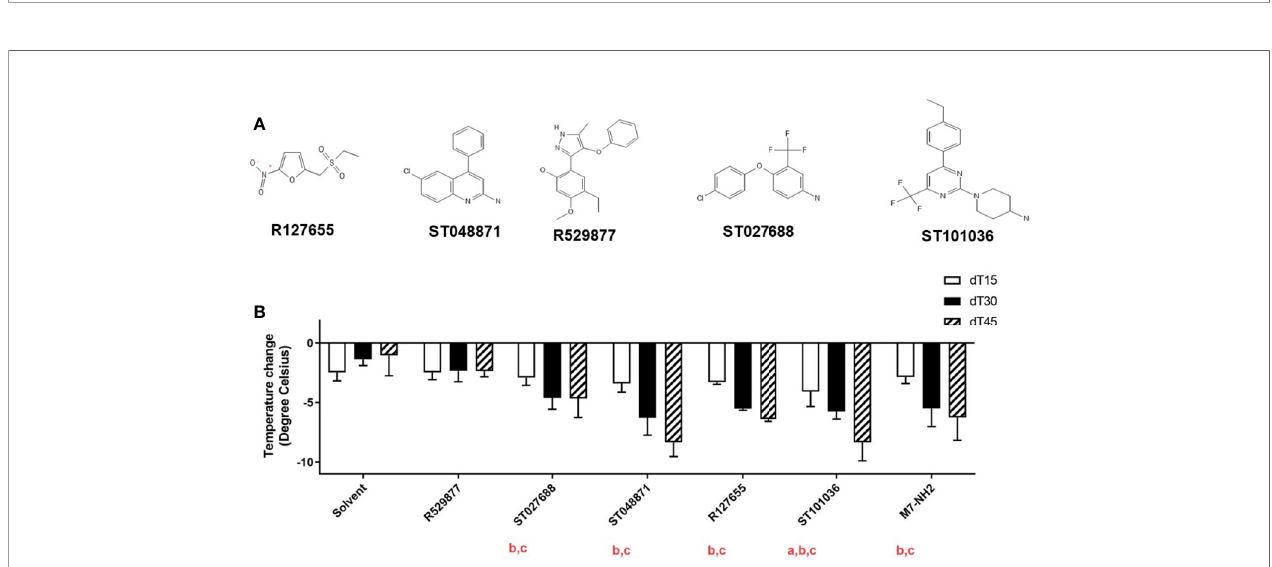
FIGURE 3 | Small molecule mast cell activators induce mast cell activation after intraperitoneal injection. Five mast cell activating compounds (A) (20 m moles) or M7- NH2 (200 nmoles) were injected in the peritoneal cavity of naïve BALB/c mice (n= 3-12 mice per group) to monitor for mast cell activation via hypothermia secondary to mast cell degranulation (B) . Temperatures were recorded before compound exposure and every 15 minutes after exposure for 45 minutes. Change in body temperature was determined by subtracting pre-exposure temperature from the temperatures recorded 15, 30, and 45 minutes after compound injection. One-way ANOVA determined if compounds induced a signi fi cant decrease in core body temperature compared to solvent at a: 15 minutes, b: 30 minutes, and c: 45 minutes after exposure. Bars represent the mean +